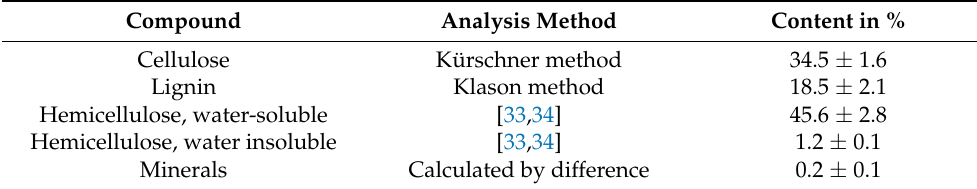
Table 1. The lignocellulose composition of the collected macroalgae Cladophora glomerata .